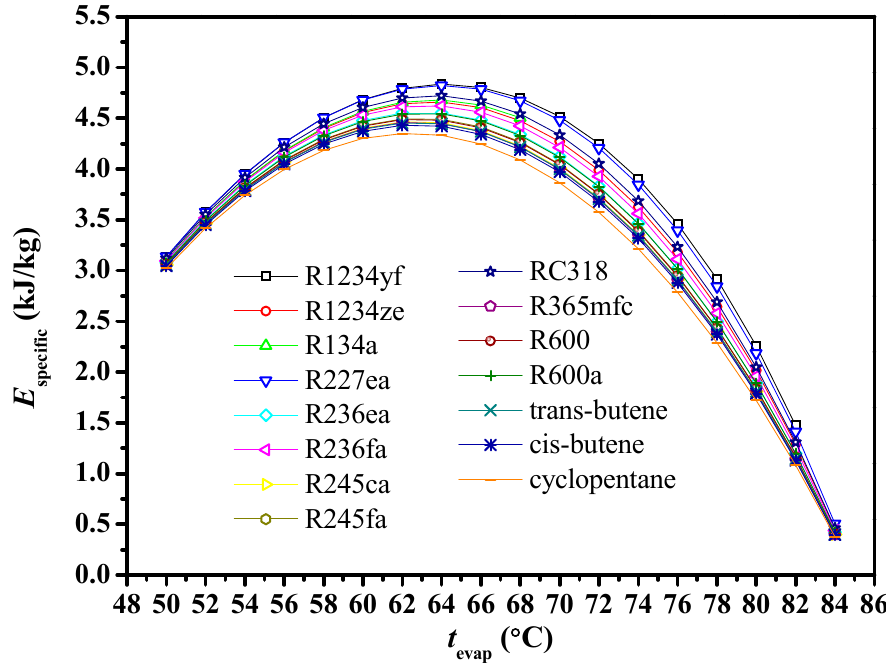
Figure 8. Variation of specific energy with evaporating temperature.